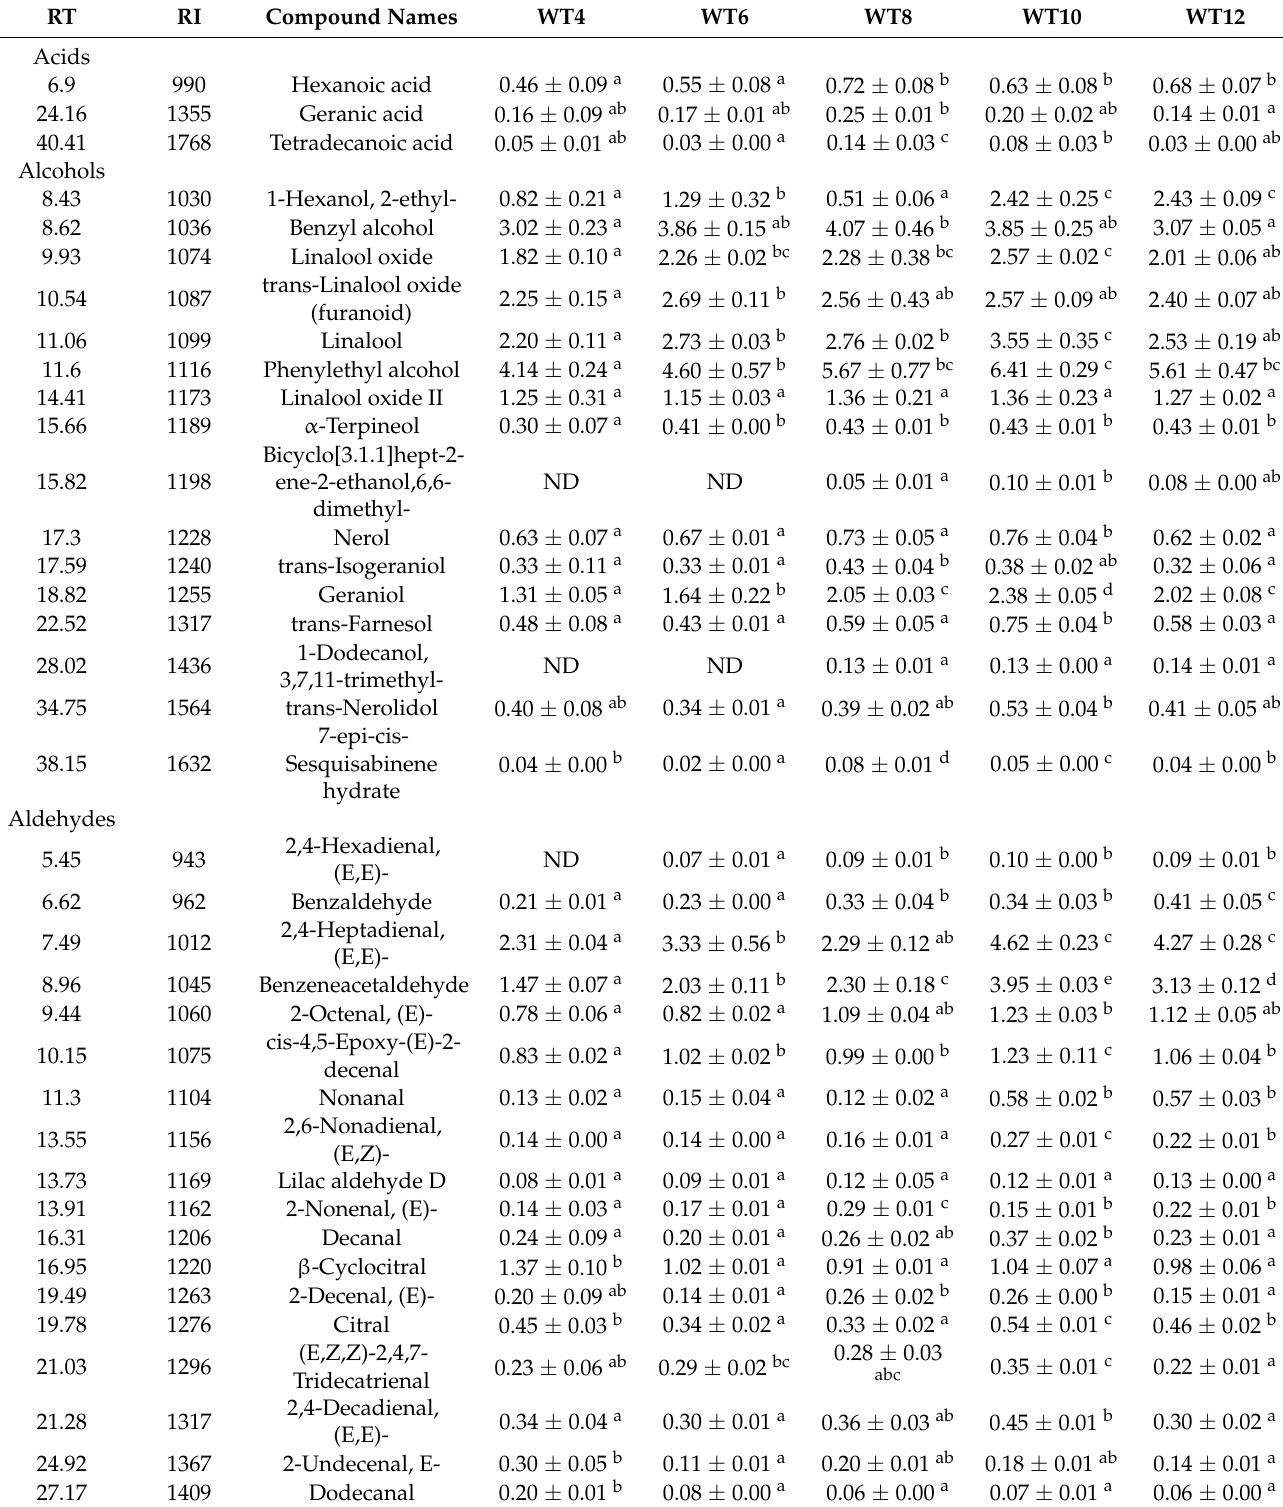
Table 3. Effect of different withering times on the volatile compounds of black tea ( µ